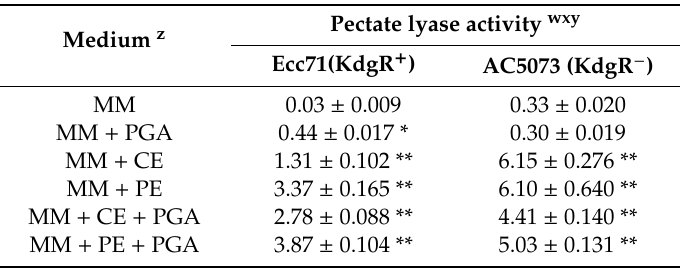
Table 2. Levels of pectate lyase produced by a KdgR − mutant and parental strain in filtered extract- supplemented